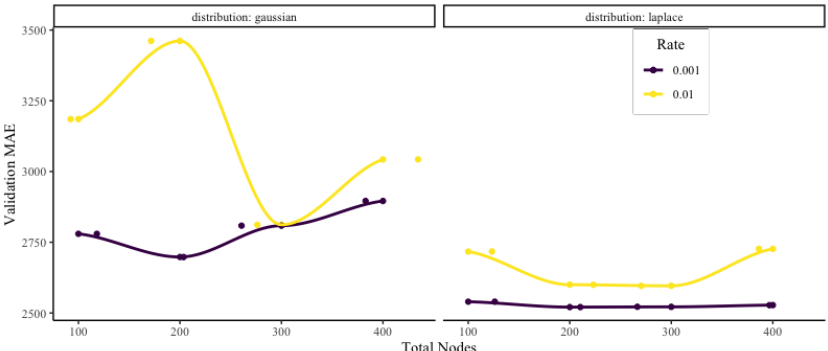
Figure 13. Visualization of the results from tuning deep learning models to predict severity on the PD data. Validation MAE is shown as a function of the total nodes in the neural network, with each pane showing a different distributional assumption of the network and each line representing a different learning